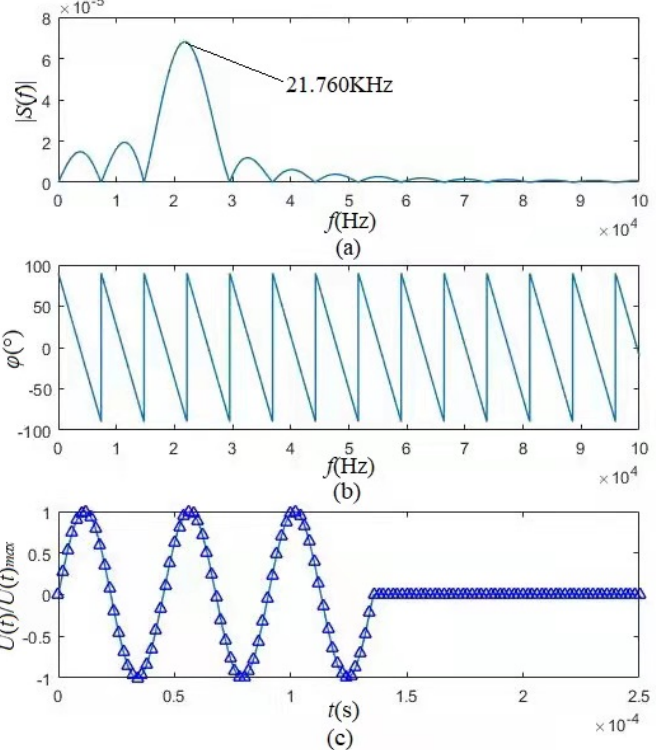
Figure 8. Amplitude spectrum, phase spectrum, and time-domain waveform of the gated sinusoidal driving-voltage signal. ( a ) Amplitude spectrum; ( b ) Phase spectrum; ( c ) Theoretically calculated time-domain waveform (solid line) and synthesized time-domain waveform (triangle-line) with the amplitude and phase spectra of the gated sinusoidal